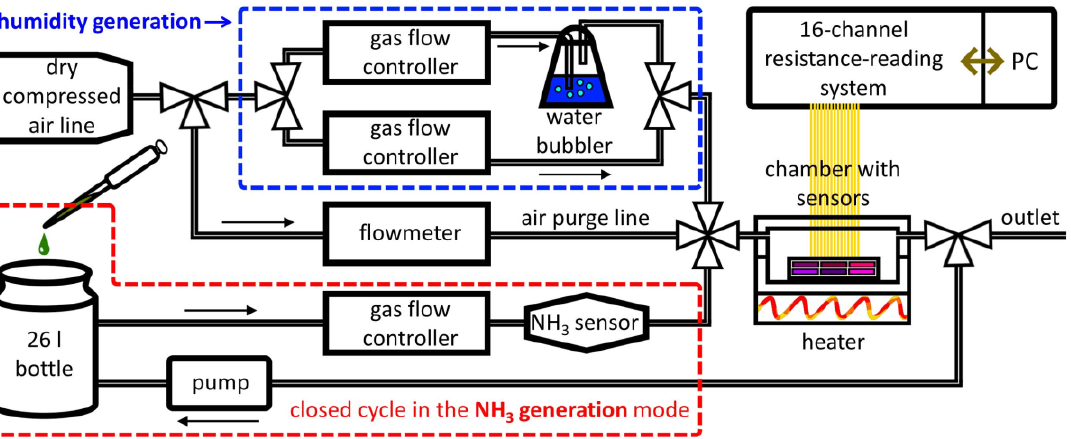
Figure 2. The gas-supply setup to feed the multisensor array under study for exposing to H 2 O an NH 3 vapors of various concentrations. The sealed chamber containing the sensors is equipped with built-in heater. Data collection is carried out by a resistance measurement unit equipped with multiple relays to be managed by a personal computer (PC).